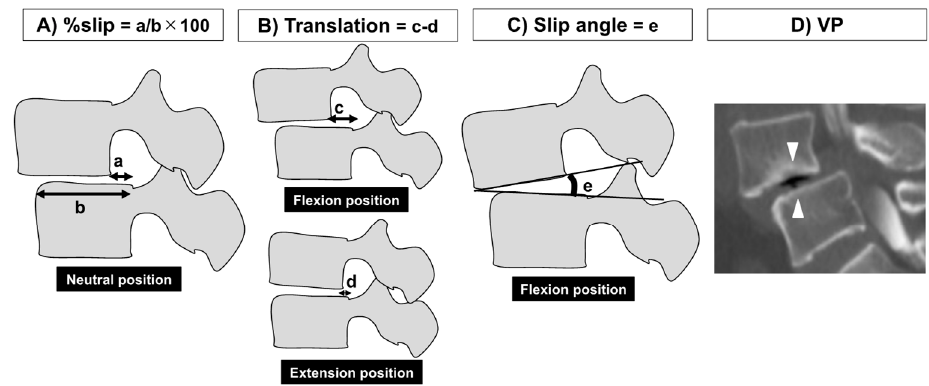
Figure 2. Measurement parameters for evaluating spinal instability. ( A ) Percentage slippage (%slip), ( B ) dynamic translation, which was the difference in segmental slippage between the flexion and extension positions (Translation), ( C ) the slippage angle in the flexion position (Slip angle), and ( D ) the vacuum phenomenon (VP) on sagittal views of computed tomography scans were measured.